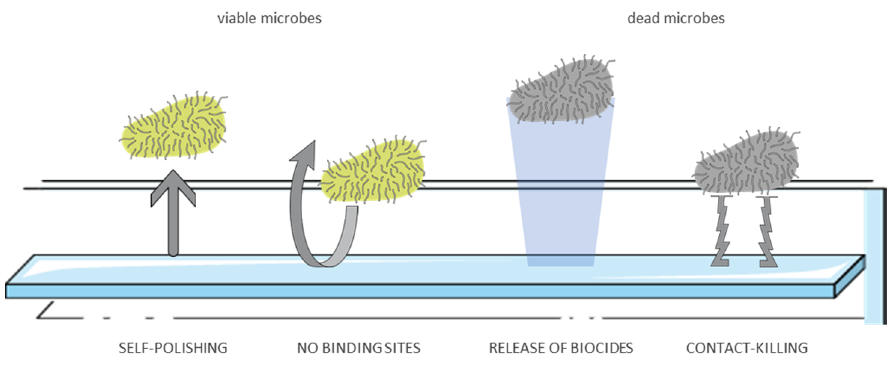
Figure 14. General classes of antimicrobial